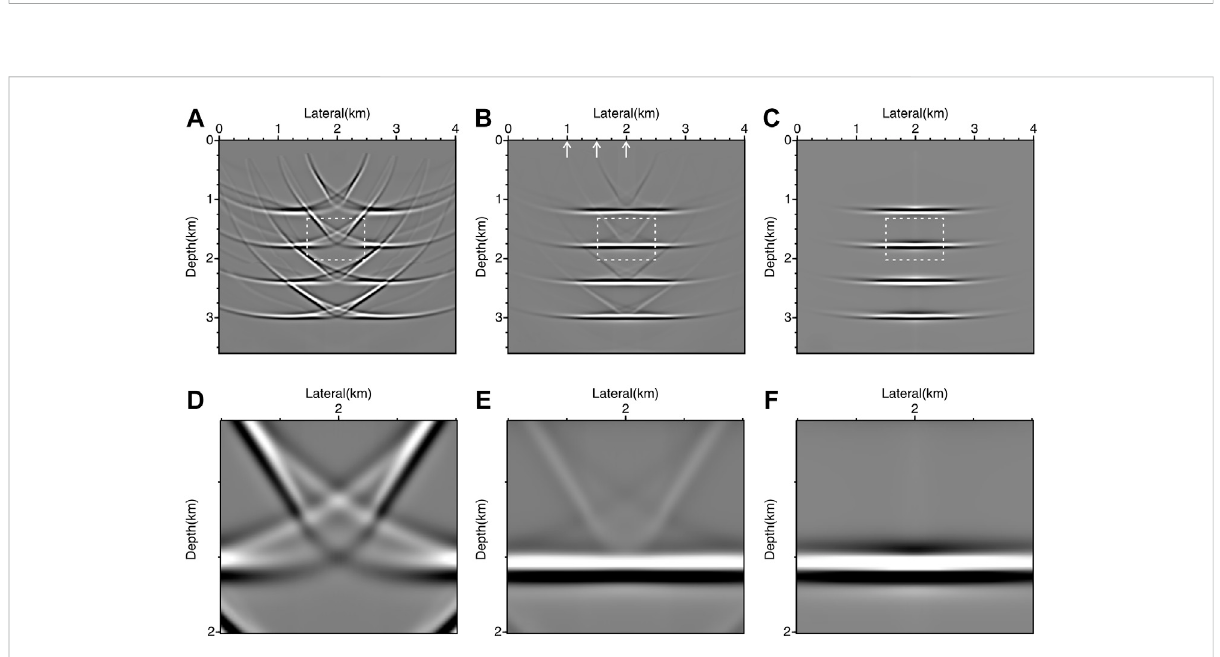
FIGURE 5 The imaging results using (A) two boundary shots by conventional GRT, (B) total shots by conventional GRT, and (C) total shots by weighted DDGRT. (D – F) are the enlarged views of the corresponding area marked by the white dotted boxes.